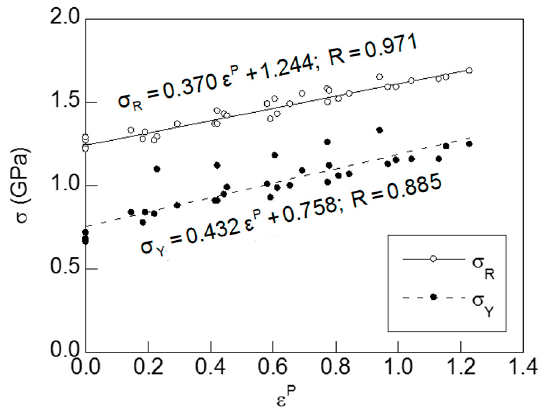
Figure 8. Mathematical fitting of the evolution of the mechanical properties (yield strength and UTS) with cumulative plastic strain of cold ‐ drawn wires.